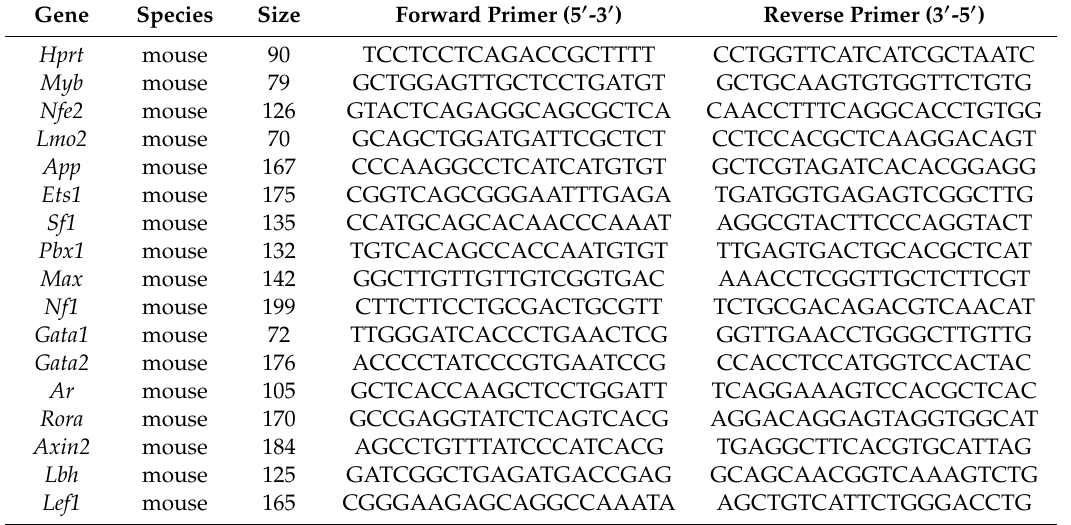
Table A1. Nucleotide sequence of the primers used for